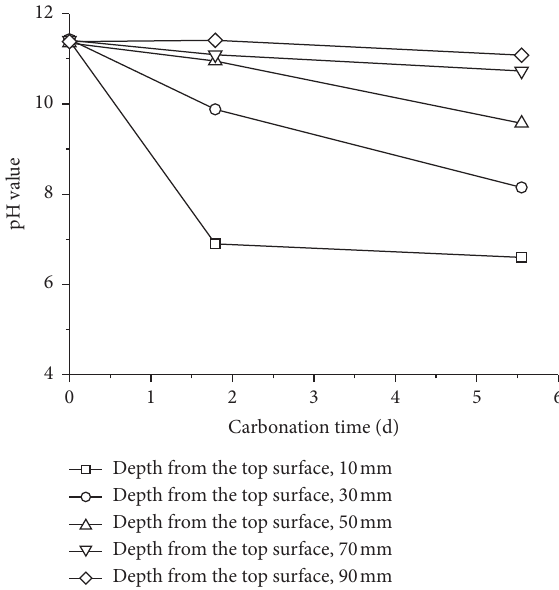
Figure 10: Evolution of carbonation extent with time of lime-stabilized expansive soil.